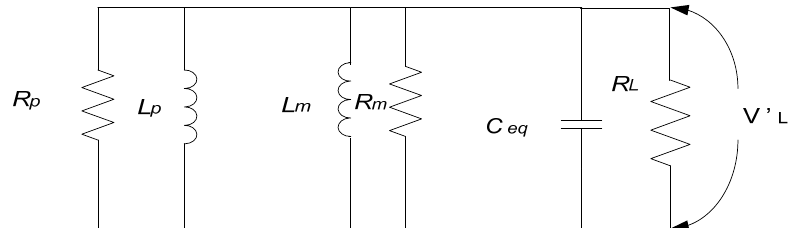
Figure 3. Equivalent stator and load